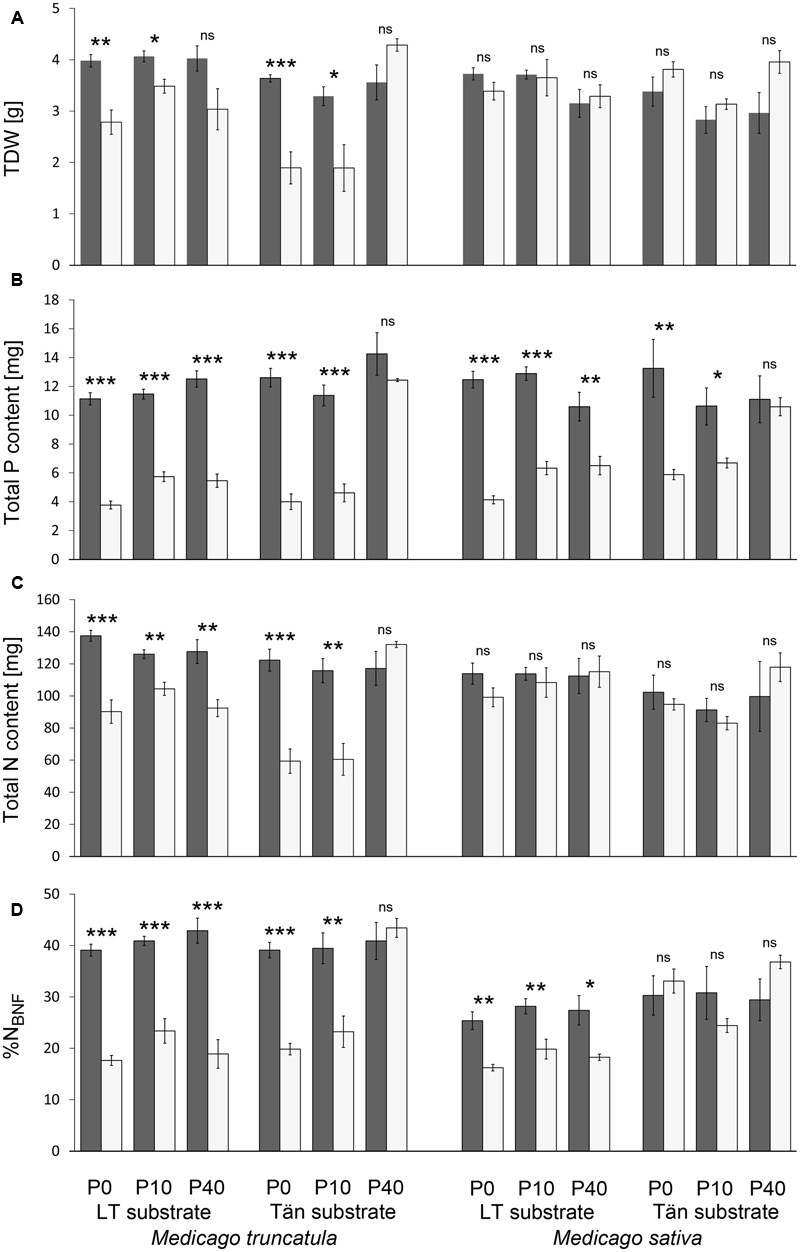
Total plant dry weight (TDW) (A), total phosphorus (P) content (B), total nitrogen (N) content (C), and fraction of plant N derived from biological N fixation (%NBNF) (D) of mycorrhizal (dark columns) or non-mycorrhizal (light columns) M. truncatula or M. sativa plants grown in sand–zeolite substrate with 10% of either Litoměřice or Tänikon soil (LT or Tän substrate, respectively). The substrate was amended with 0, 10, or 40 mg pot-1 of phosphorus (P0, P10, and P40, respectively). Bars represent means ± standard errors (n = 4 or 5). Asterisks indicate significant differences between mycorrhizal and non-mycorrhizal plants according to t-test (∗0.01 ≤p < 0.05, ∗∗0.001 ≤p < 0.01, ∗∗∗p < 0.001; ns, p ≥ 0.05).